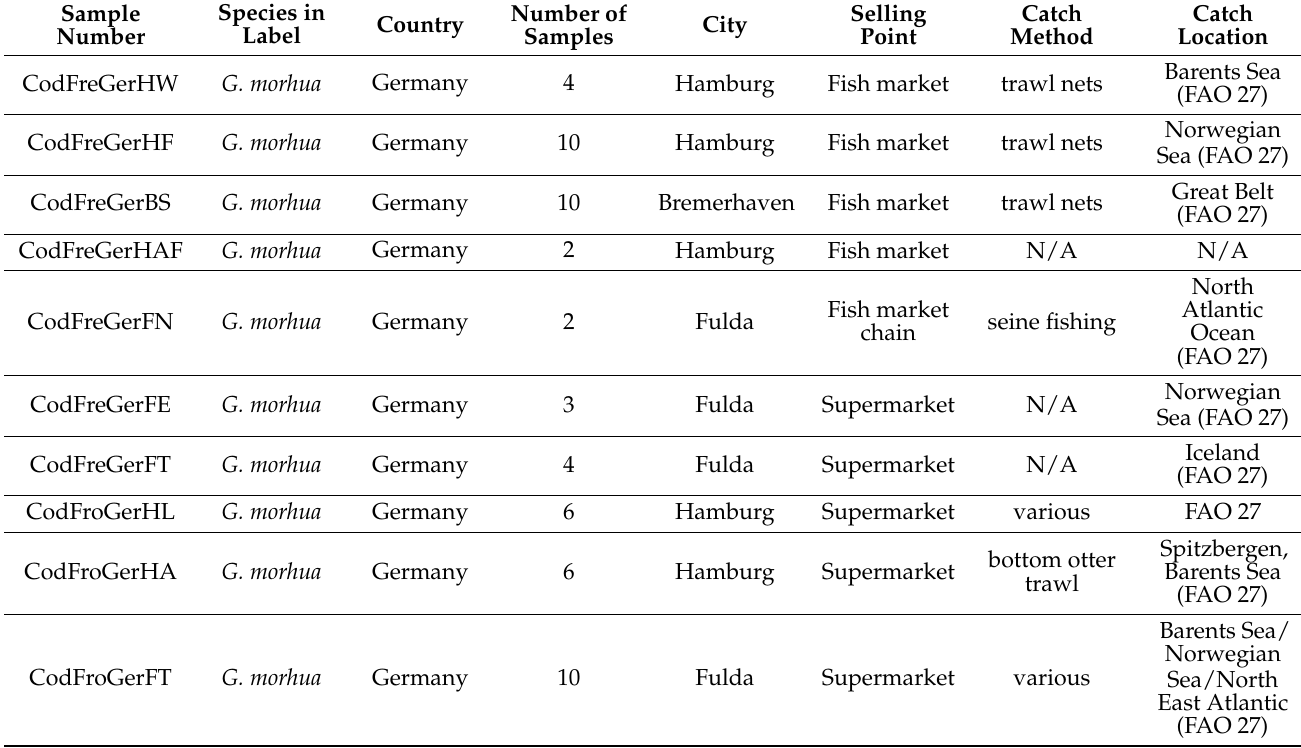
Table 1. Samples analyzed in this study and the information provided in the labels. Each sample was coded with the information of the fish, its condition (fresh/frozen), the country, city, and store of purchase. Fre, fresh; Fro, frozen; Ger, Germany; Net, the Netherlands; Fra, France; N/A, not available data. Supermarket/fish market names are not provided to keep confidentiality. (e.g., CodFroNetRA1 = Cod, Frozen, Netherlands, Rotterdam, store A). Species in Sample Number